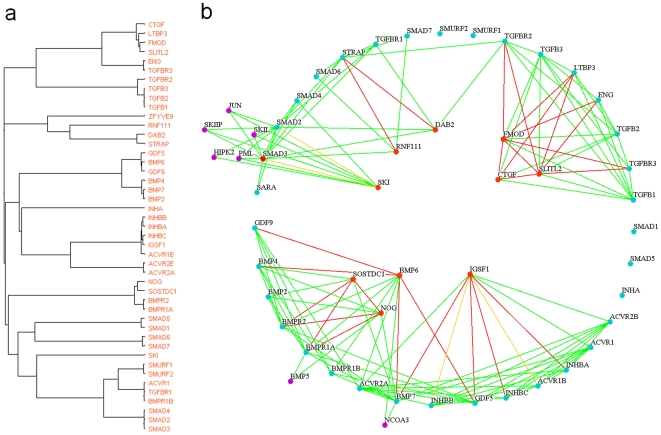
TGF-β signaling pathway–related subcluster.(a) One subcluster identified by our method consists of proteins presumably involved in the TGF-β signaling pathway. (b) Detailed interpretation of the relationships between each protein from the subcluster. On the basis of the Ingenuity Pathway Analysis 5.0, the 35 blue-green proteins on the circle participate in the TGF-β signaling pathway, and the 10 red proteins inside the circle are unrelated. The violet proteins outside the circle are common neighbors that do not belong to the subcluster in panel a. Red lines represent significant protein pairs, green lines represent direct protein–protein interactions, and yellow lines represent both.